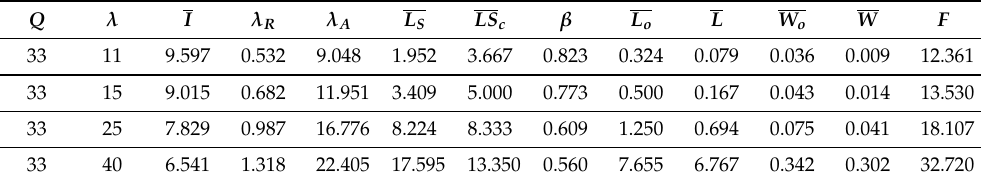
Table 4. The effect of λ on performance measures at Q = 33.